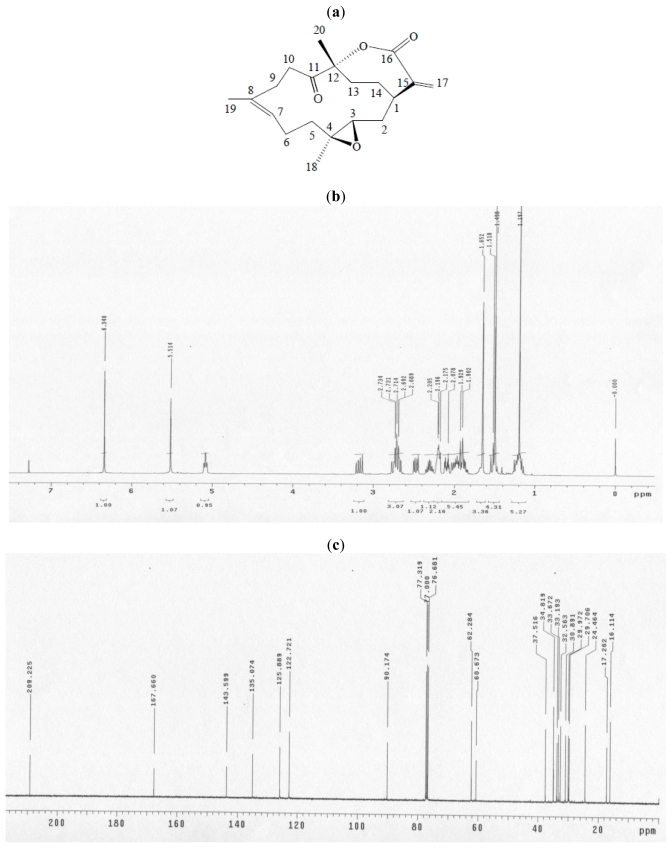
(a) Chemical structure of 11-dehydrosinulariolide; (b) 1H NMR spectrum of 11-dehydrosinulariolide in CDCl3 at 400 MHz; (c) 13C NMR spectrum of 11-dehydrosinulariolide in CDCl3 at 100 MHz.